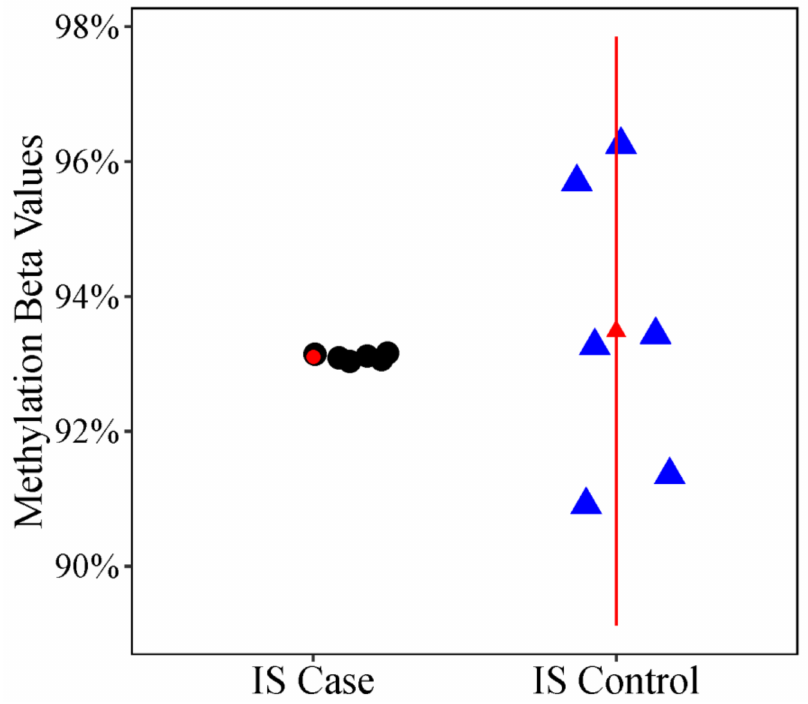
Figure 3. Scatter Plot of Differential Variability Between Case and Control Twins. Methylation levels (% methylation or β values) at the cg12959265 probe, an open sea probe near the DPY19L1 gene on chromosome 7 in IS cases and IS controls. The triangle represents the mean % methylation and error bars represent +/ − 1 standard deviation. The plot illustrates the large difference in variability at cg12959265 in IS cases vs. IS